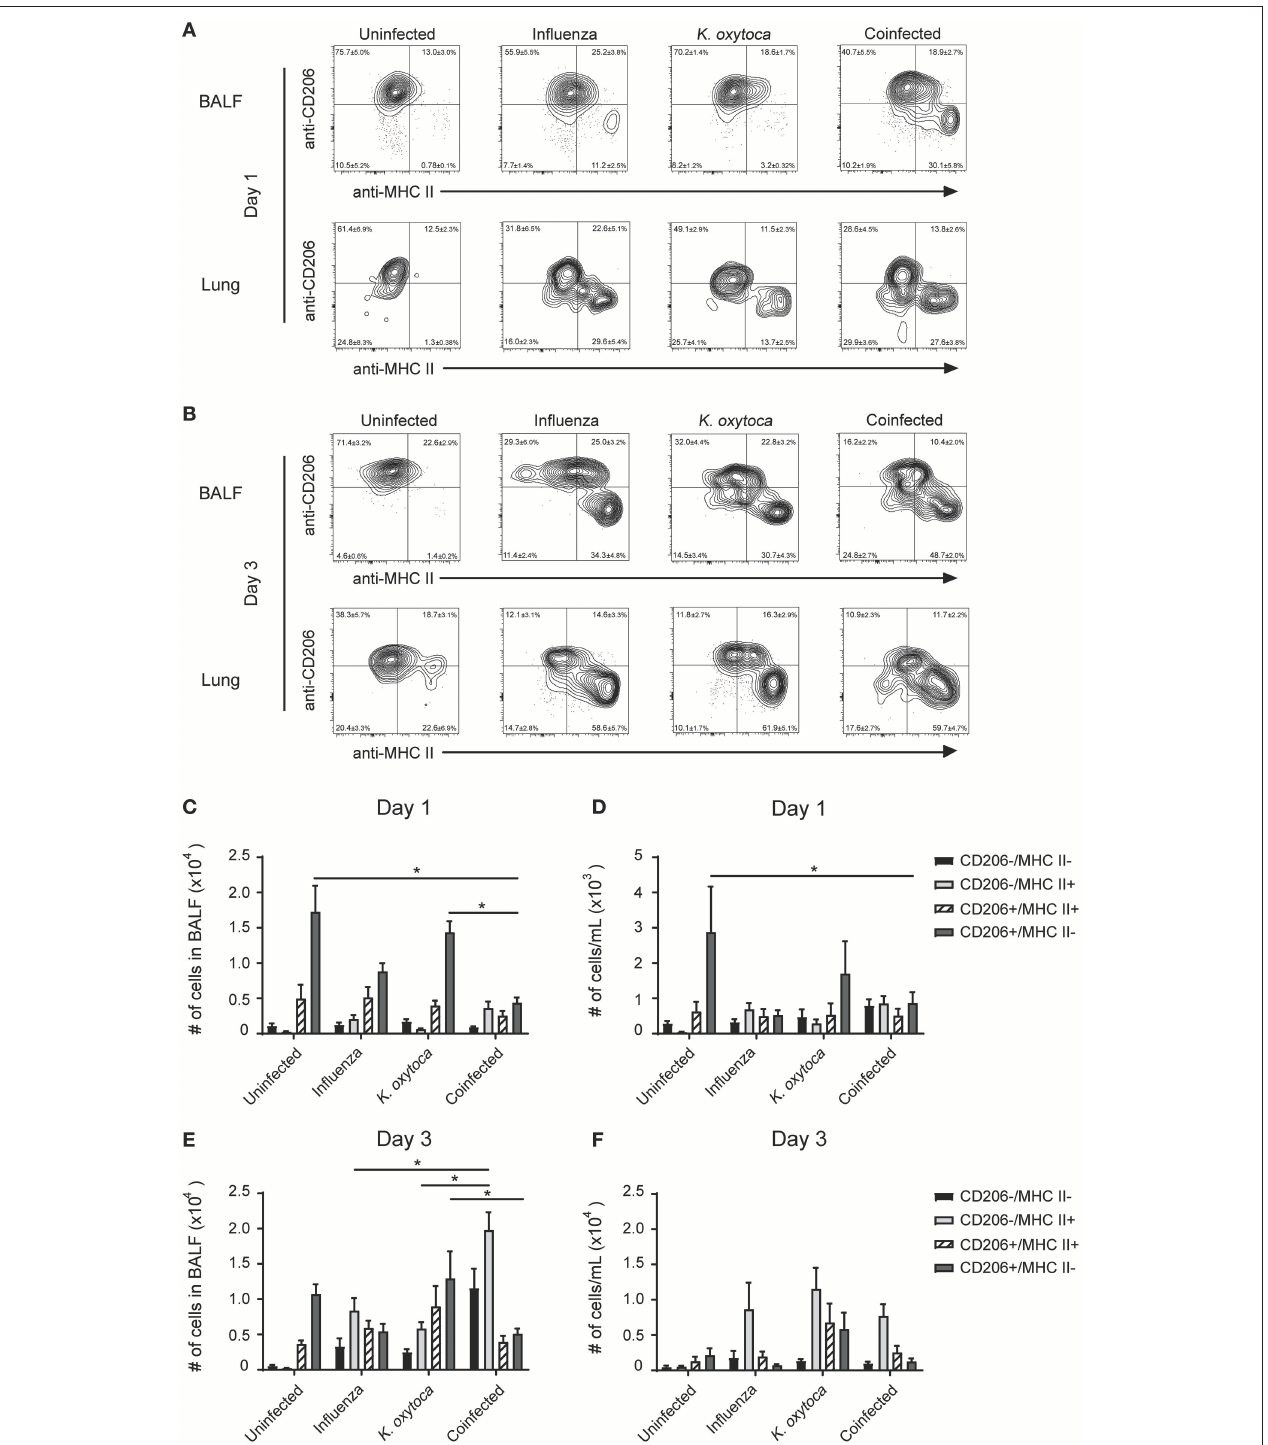
FIGURE 5 | Macrophage populations in coinfected mice have increased MHC II and decreased CD206 compared to singly-infected mice. Ly6G − F480 + CD11c + macrophages in the BALF and lung tissue were analyzed for the expression of the MHC II and CD206 on days 1 and 3 post- K. oxytoca infection (A,B) . Macrophage subsets were classified as CD206 − MHC II + , CD206 + MHC II + , CD206 + MHC II − , and CD206 − MHC II − and quantified in the BALF (C,E) and lung tissue (D,F) on days 1 and 3 post- K. oxytoca . * denotes P ≤ 0.05 between indicated groups. Data were analyzed with ANOVA followed by Tukey’s multiple comparison tests. Error bars represent SEM. Data are combined from at least four independent experiments with at least four mice per group.